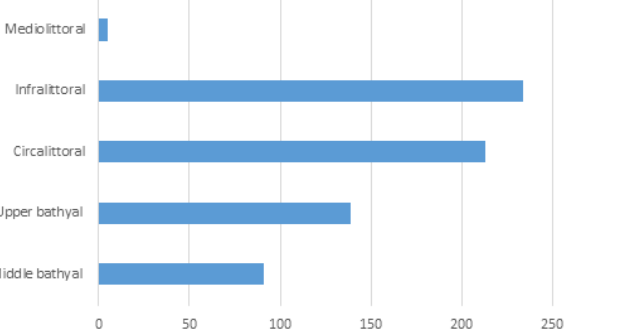
Figure 5. Number of fish species in each depth zone of the Adriatic Sea benthic environment.